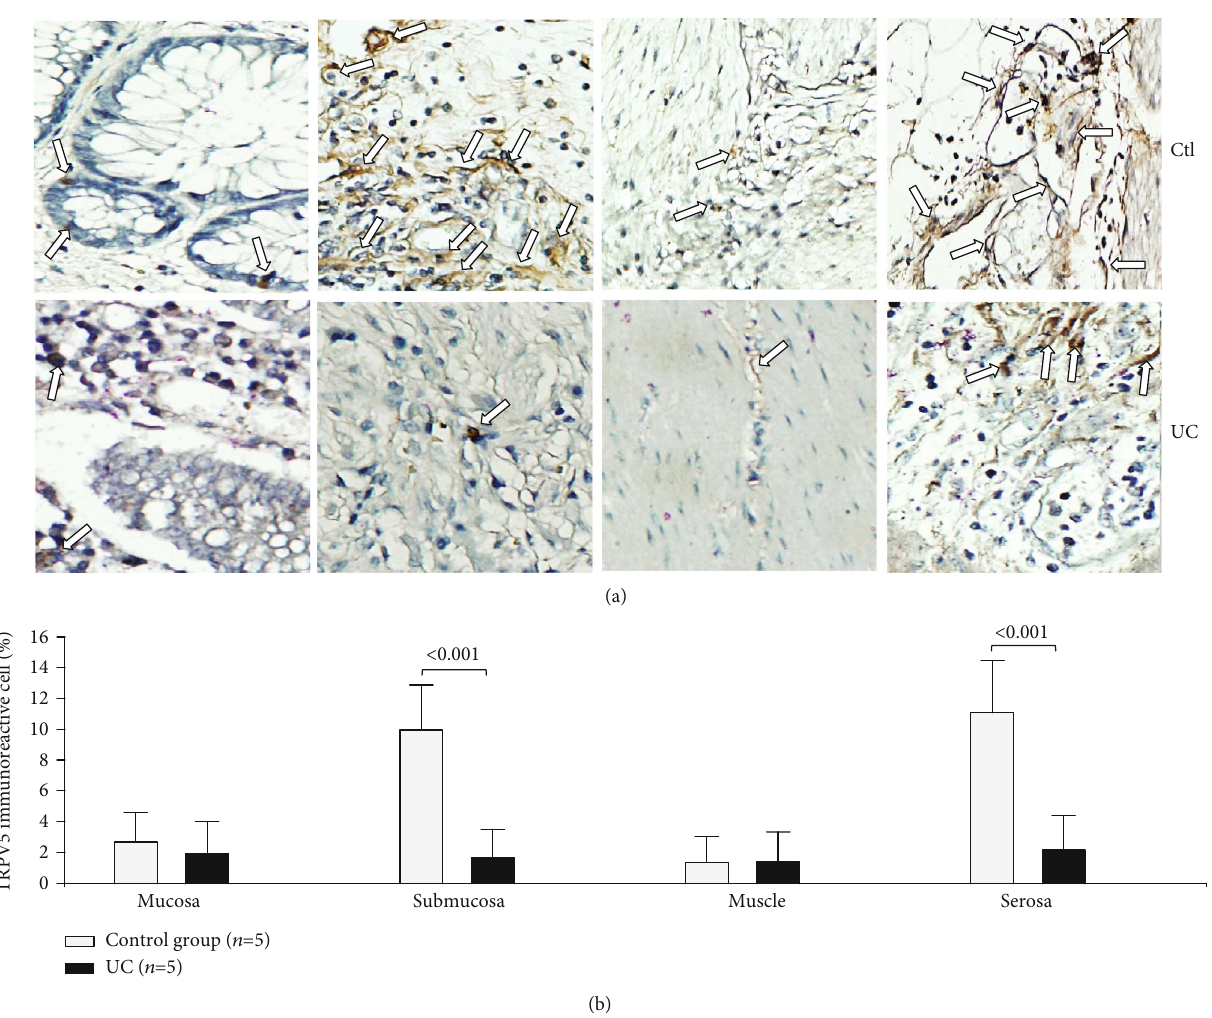
Figure 5: Protein expression of TRPV5 in intestinal tissue from patients with UC and controls. TRPV5 protein expression in slides with colonic tissue obtained from patients with severe ulcerative colitis and nonin fl amed colonic tissue. (a) Immunoperoxidase photomicrographs of ulcerative colitis (lower panel, n = 5 ) and non-IBD colonic tissue (control; upper panel, n = 5 ). Arrows indicate TRPV5 immunoreactive cells in the mucosa, submucosa muscular, and serosa layers. Original magni fi cation was × 320. (b) TRPV5- producing cell percentage in nonin fl amed colonic tissues (control, n = 5 ) and active UC patients ( n = 5 ) is shown in